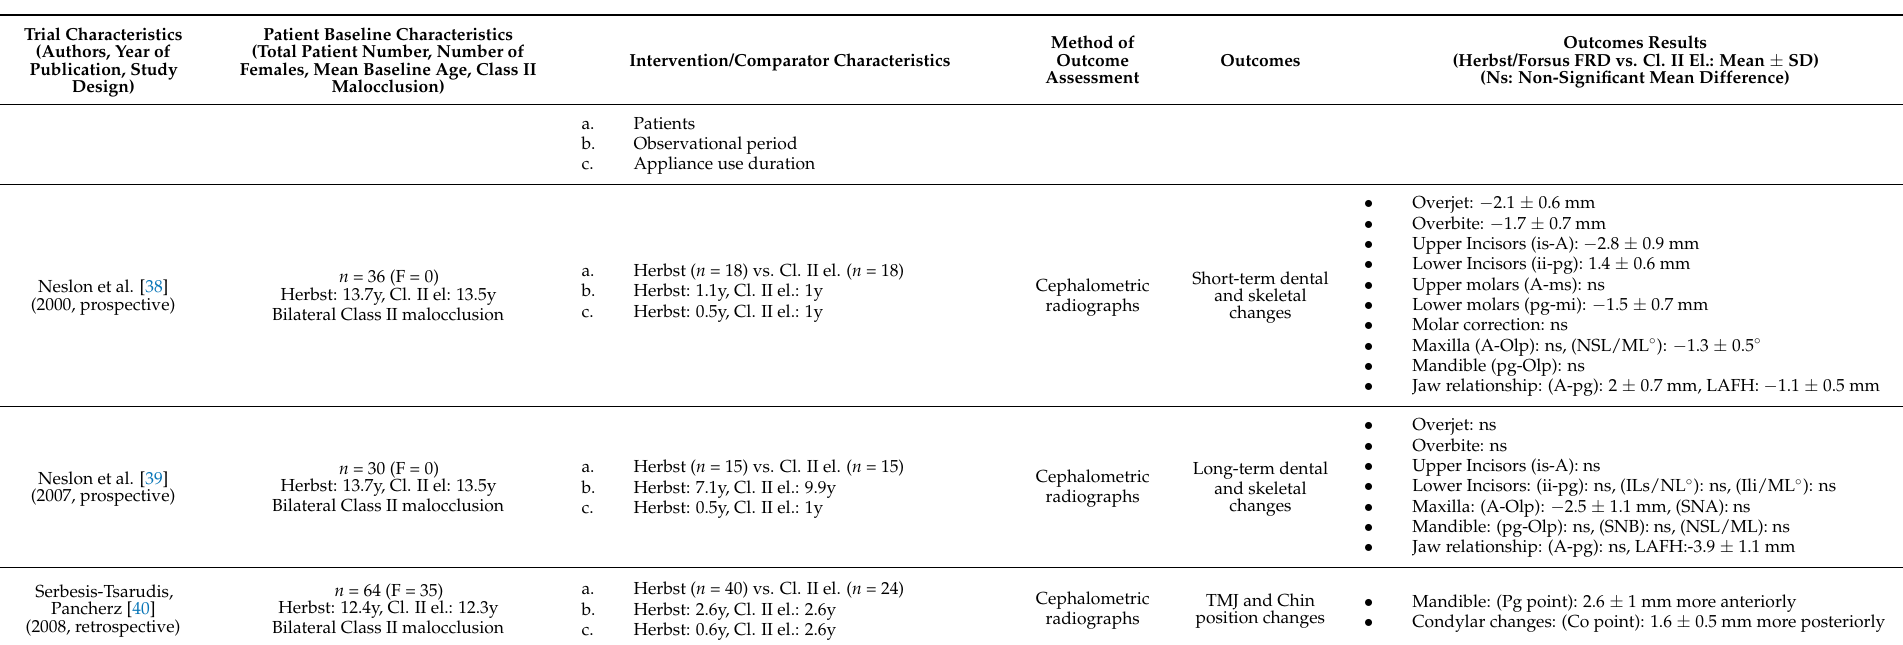
Table 1. Summary of